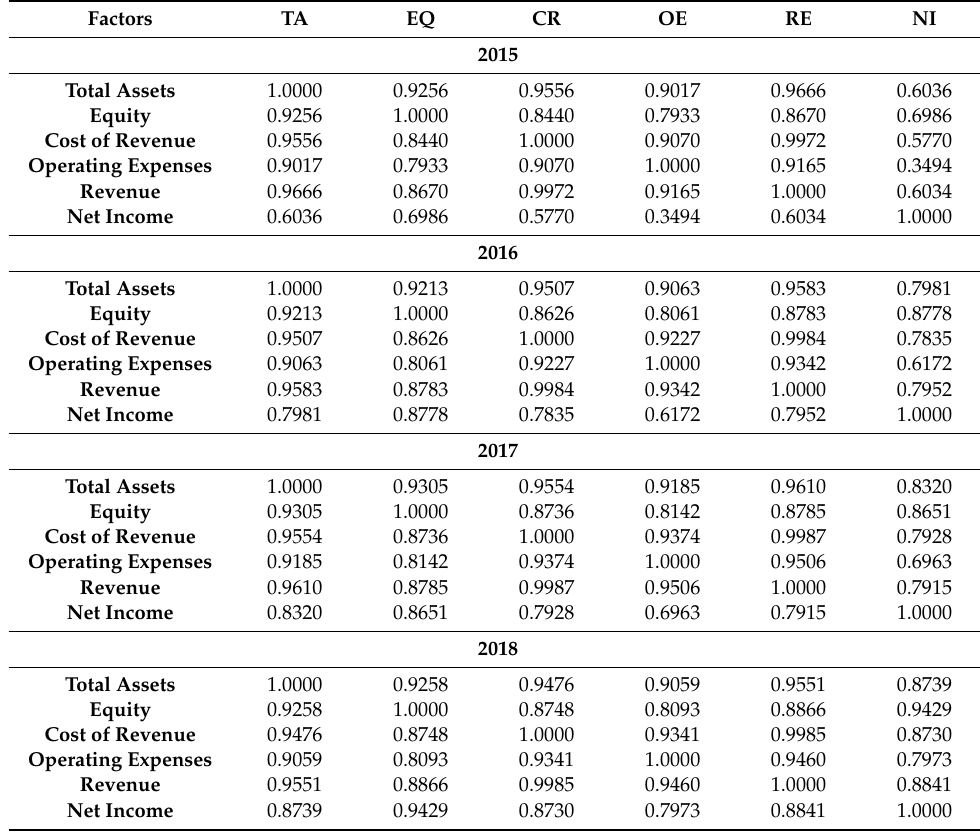
Table 3. Coe ffi cients of correlation between